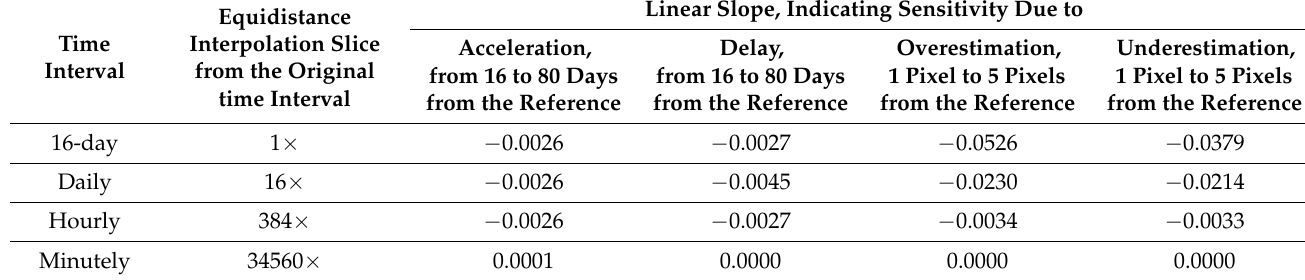
Table 5. Sensitivity summary of the method on hypothetical temporal data sets on deforestation after interpolation at a time slice of 16 days, 1 day, 1 h, and 1 min, due to the possibility of (a) acceleration, (b) delay, (c) overestimation, and (d) underestimation of deforestation detection, compared to the